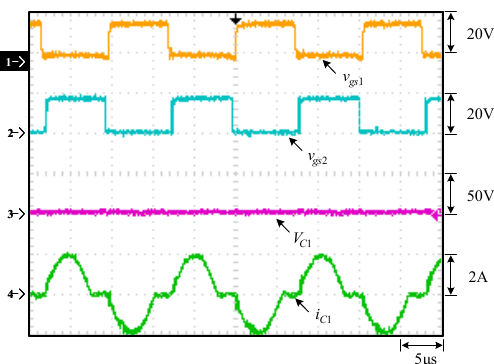
Figure 15. Waveforms at rated load: (1) v gs 1 ; (2) v gs 2 ; (3) i D 1 ; (4) i D 2 .